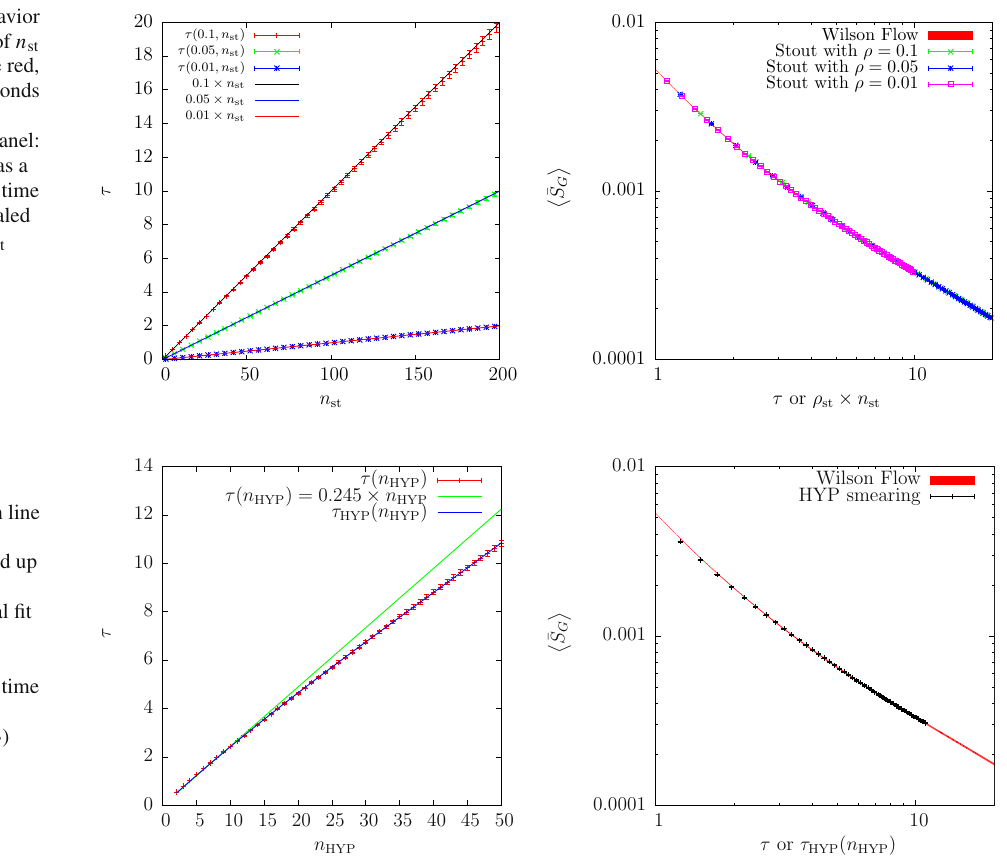
05Stout with ρ = 0 . 01Stout with ρ = 0 .